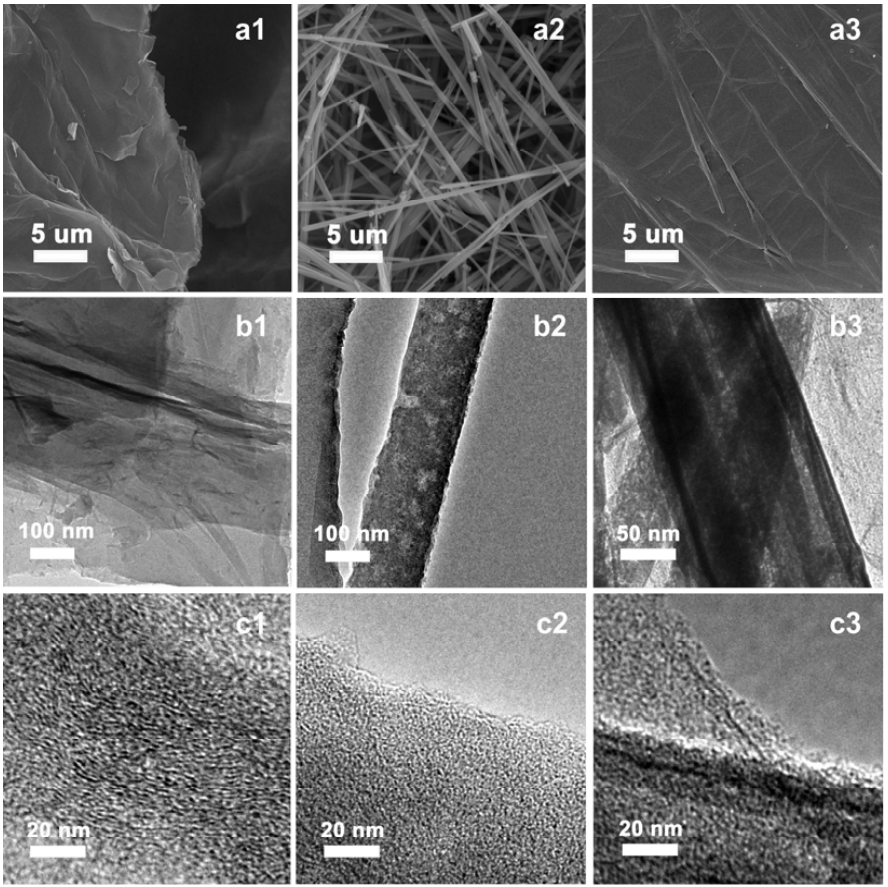
Figure 2. SEM, TEM, and HR-TEM images of rGO ( a1 , b1 , c1 ), FPCFs ( a2 , b2 , c2 ), and PNCFs@rGO ( a3 , b3 , c3 ).